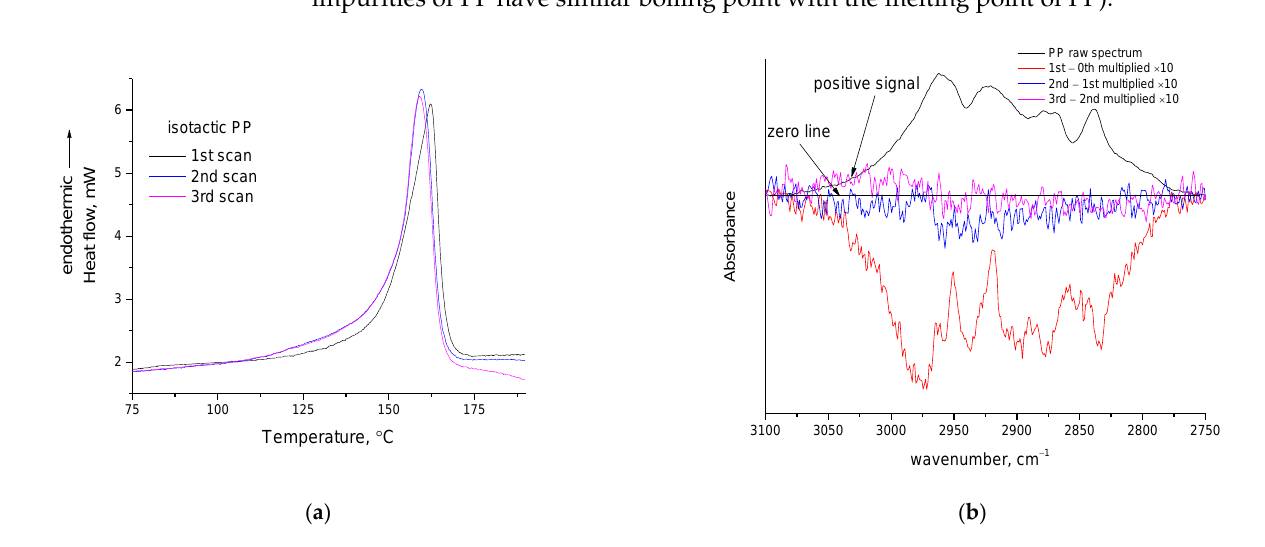
Figure 6. ( a ) Three consecutive DSC scans of isotactic PP sample; ( b ) FTIR spectrum of PP raw material and subtracted spectra before and after three consecutive heating cycles at 170 °C in the region 3100–2750 cm −1 .